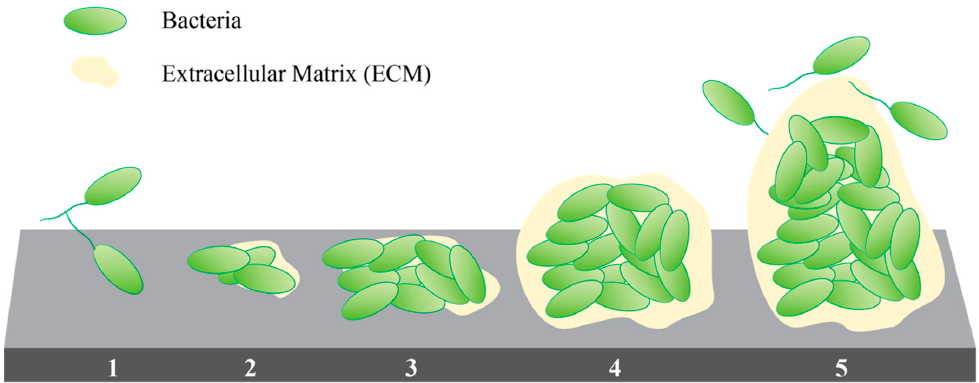
Figure 2. Stages of biofilm development: (1) Reversible attachment, (2) Irreversible attachment, (3) Maturation 1, (4) Maturation 2, and (5) Dispersion [76] .